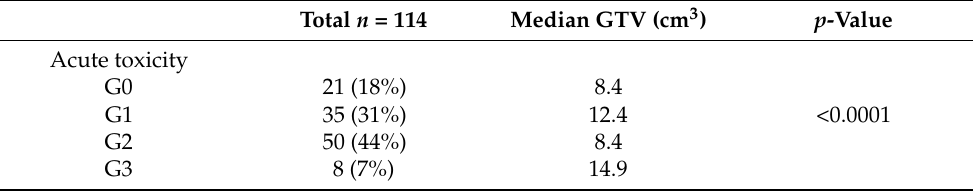
Table 4. Associations of grade 3 acute and late toxicity with GTV.